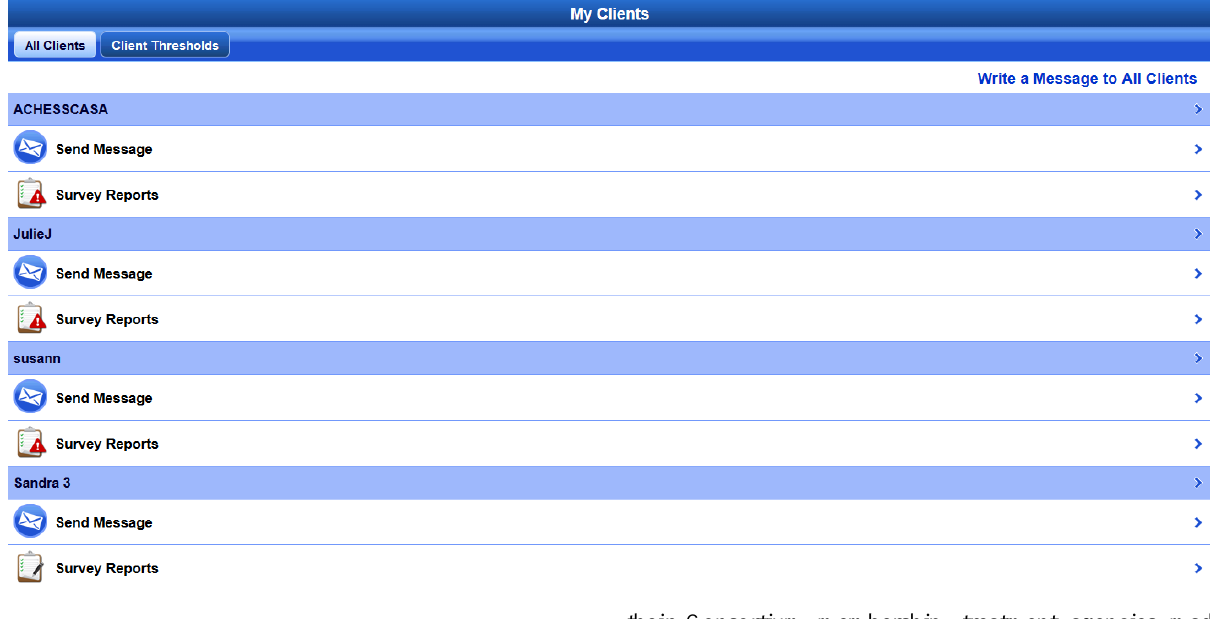
Figure 3. Screenshot of A-CHESS counselor home